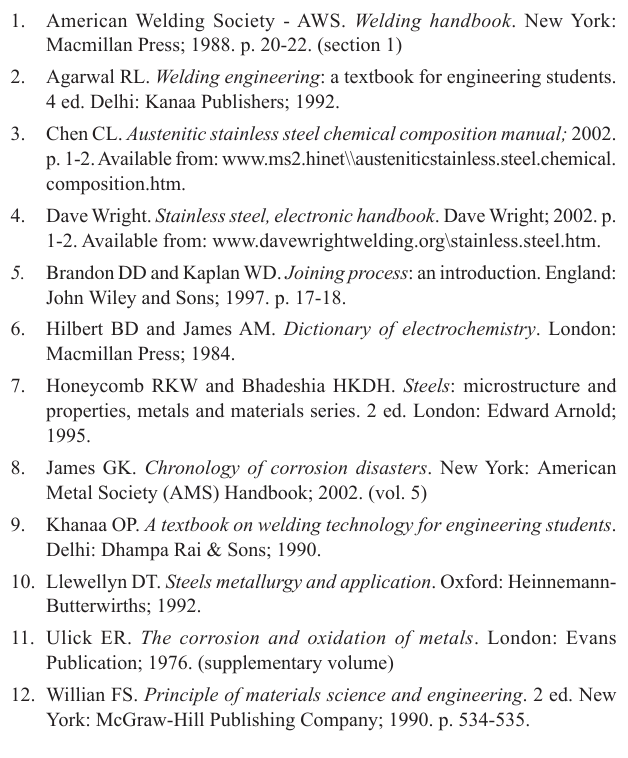
Figure 3. Plot of electrode potential vs. exposure time of austenitic stainless steel welded at various post-weld heat treatments.